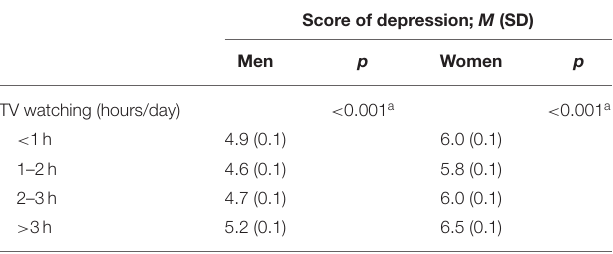
TABLE 2 | Relationship between time spent watching TV and the score of depression in 2014. Score of depression; M (SD)